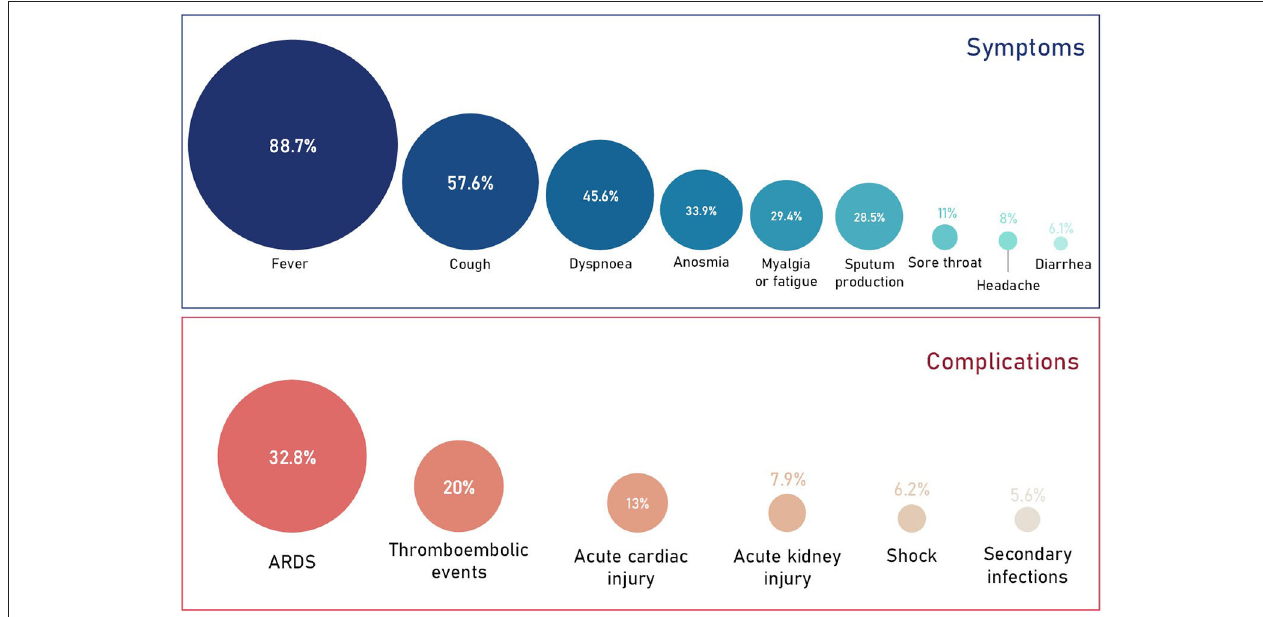
FIGURE 1 | Prevalence of COVID-19 symptoms and complications. Data obtained from a quantitative meta-analysis of 19 studies (19). It’s important to note that 87% of all cases analyzed in the meta-analysis were hospitalized cases. Therefore, the proportion of symptoms and complications are representative of this and the overall proportions with regards to all COVID-19 cases will be much lower. The prevalence of anosmia (20) and thromboembolic events (21) were obtained independently from smaller cohorts and may therefore change as more data is published.